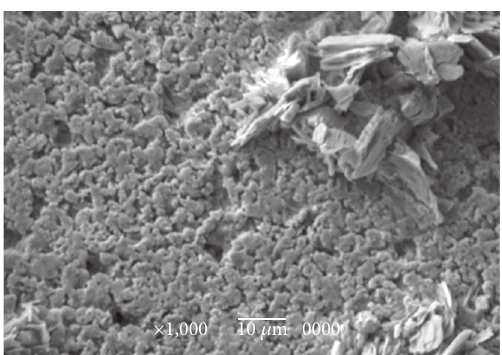
Figure 9: Derm-skin sca ff old with collagen sheet, without cells, at SEM magni fi cation × 1,000 (bar: 10 μ m). The sca ff old proved to have adequate intercompartmental space to allot and home chondrocytes to build up a fi nal cartilage-like